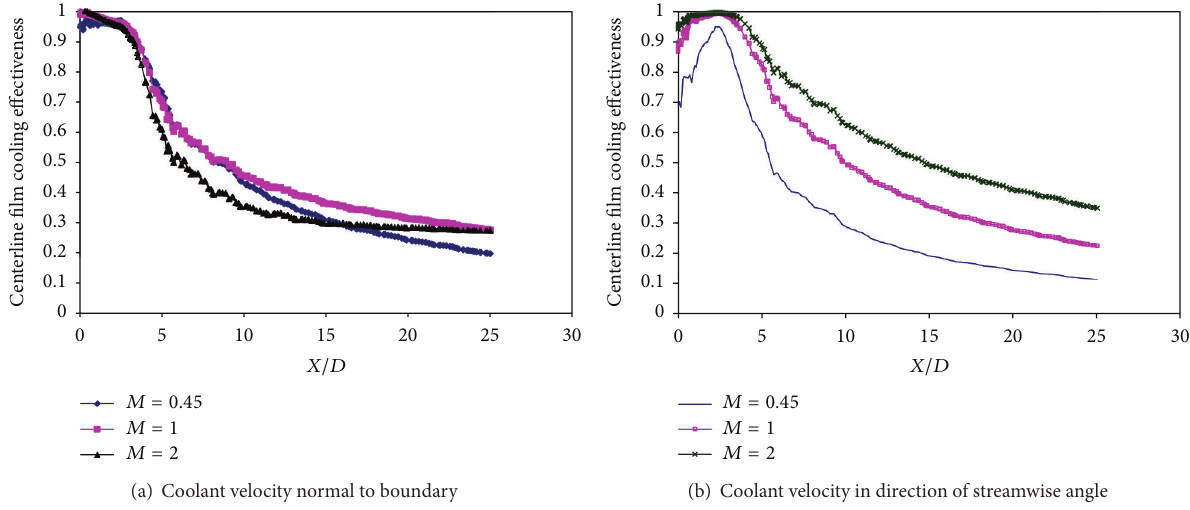
Figure 22: Centerline effectiveness versus 𝑋/𝐷 of LFDSA-15-15 hole shape for different blowing